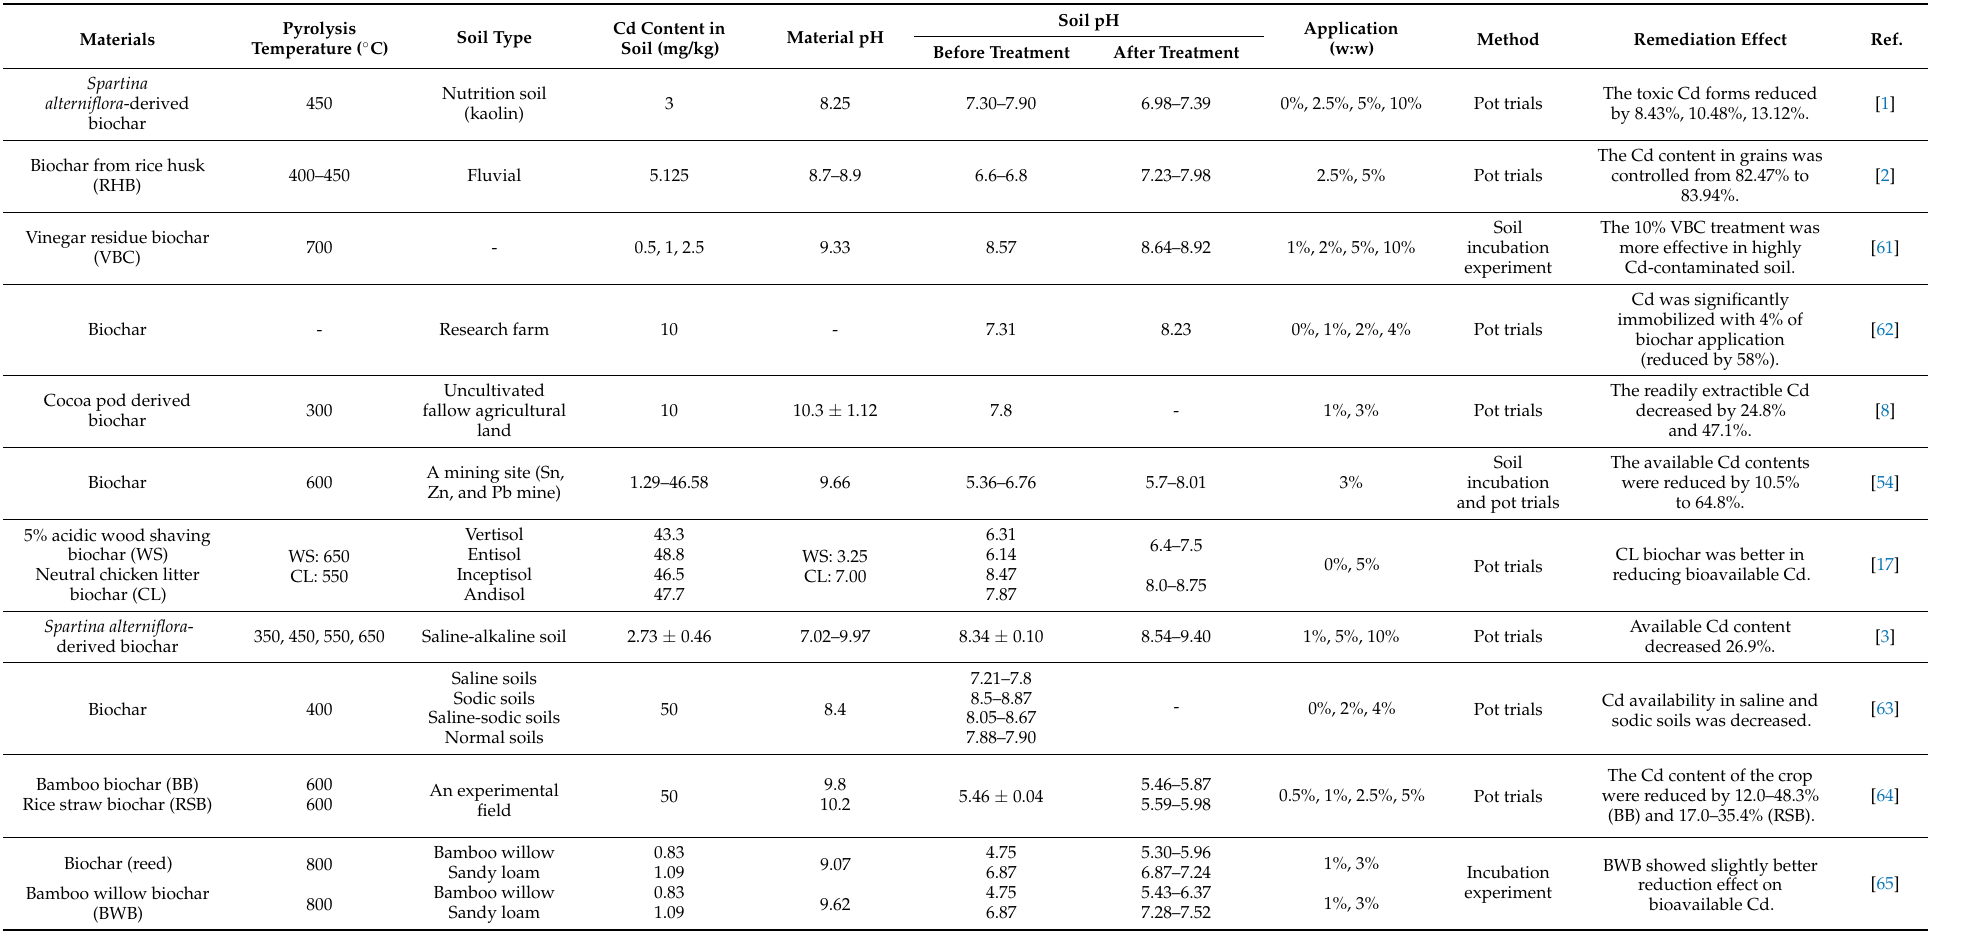
Table 2. Remediation effects of raw biochar on Cd pollution in